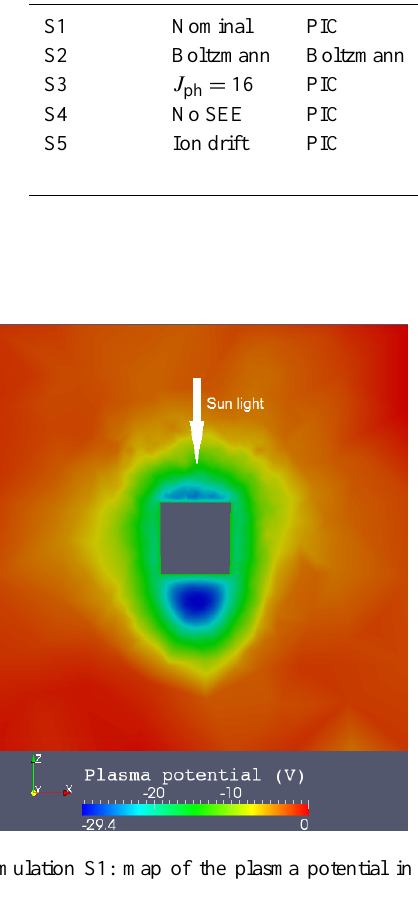
Fig. 12. Simulation S1: map of the plasma potential in a X = 0